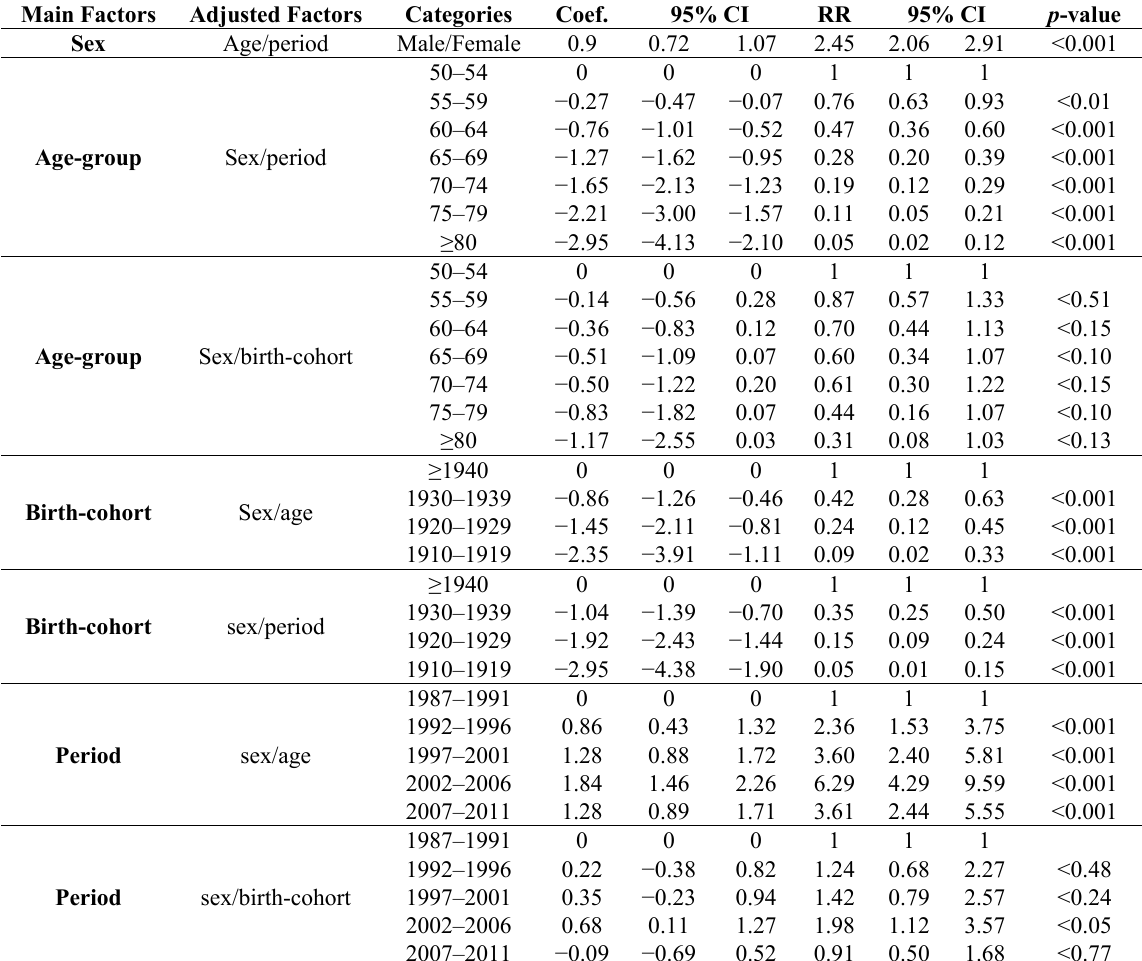
Table 2. Age, sex, period, and cohort effects on AIDS incidence 1 (age ≥ 50 years) over